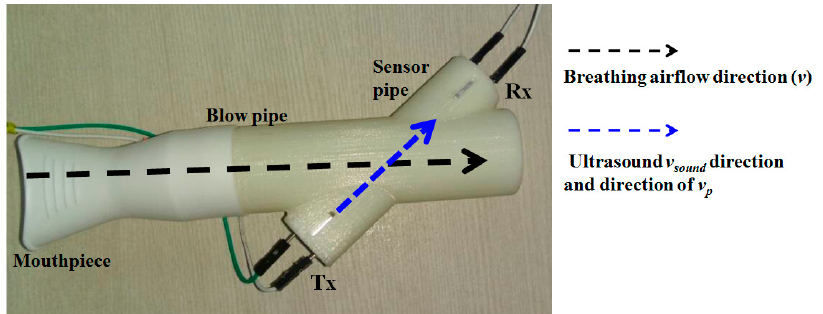
Figure 2. The 3D printed flow pipe.